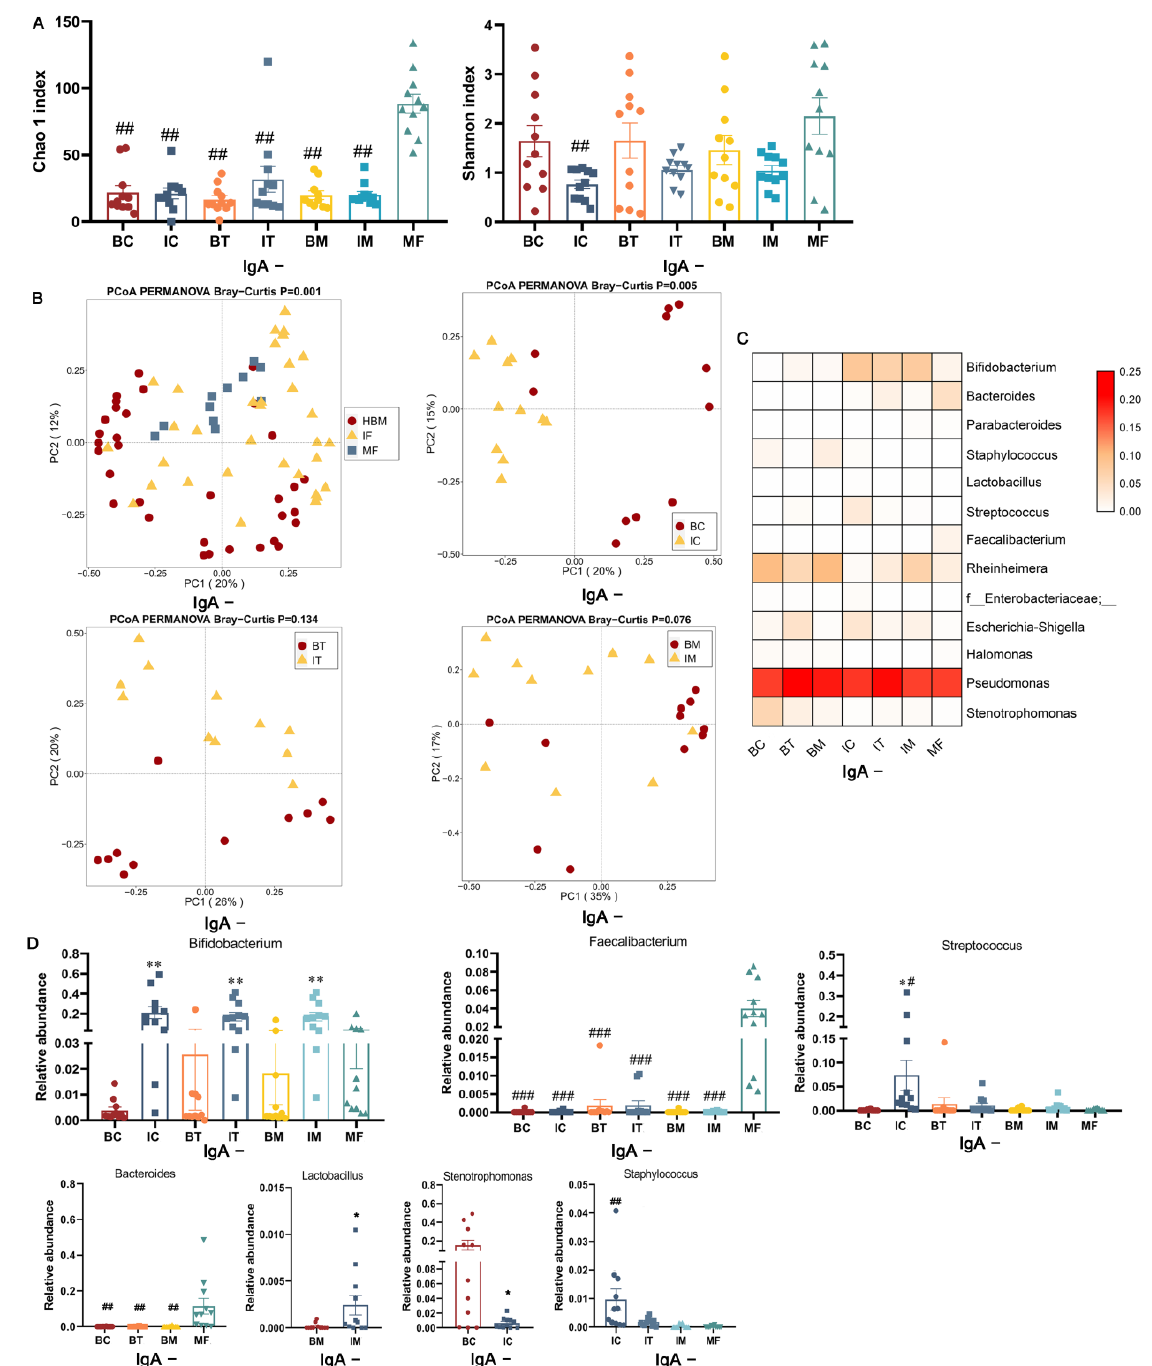
Figure 3. Diversity and composition of sIgA-uncoated bacteria in HBM, infant feces, and maternal feces. ( A ) Alpha diversity. ( B ) Beta diversity. ( C ) Heatmap of the composition of sIgA-uncoated bacteria in HBM, infant feces, and maternal feces. Genera of relative abundances > 0.01% and calculated with log10 are presented. The darker color corresponds to higher relative abundance. The Bray – Curtis distance was utilized to calculate the difference between samples using PERMANOVA. ( D ) The significantly different genera of sIgA-uncoated bacteria between different samples. *, p < 0.05; **, p < 0.01; three stages of infant feces compared to corresponding BC, BT, and BM. #, p < 0.05; ##, p < 0.01; ###, p < 0.001; three stages of HBM and infant feces compared to maternal feces. BC, BT, BM, IC, IT, and IM stand for colostrum, transitional milk, mature milk, and infant feces corresponding to HBM stages. IgA+ means IgA-coated bacteria, and IgA − means IgA-uncoated bacteria.